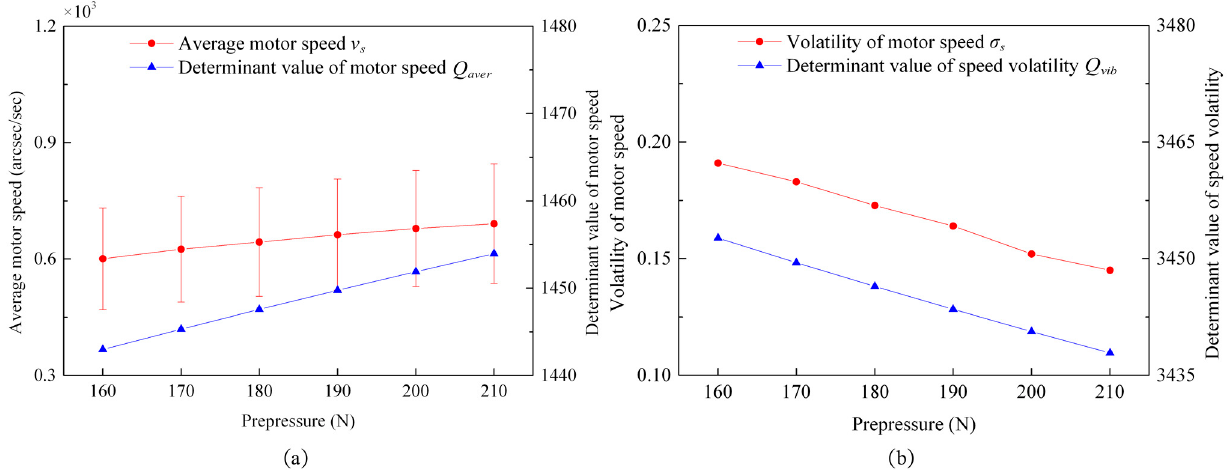
Figure 31. An experimental diagram of the variation trend of characteristic variables with prepressure: ( a ) an experimental diagram of the motor’s average speed, v s , and the motor’s average speed determining factor, Q aver , with prepressure; and ( b ) an experimental diagram of the speed volatility, σ s , and the speed volatility determinant, Q vib , with